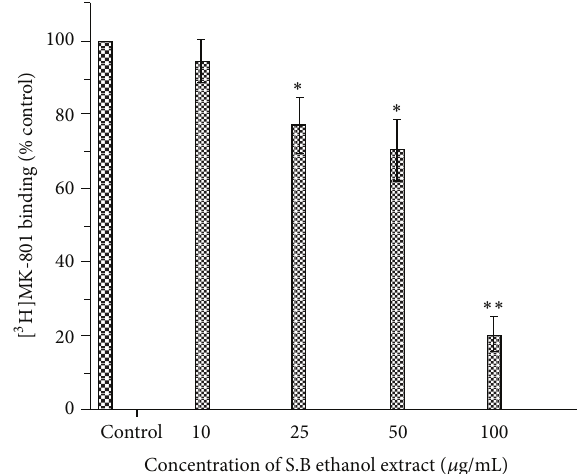
Figure 4: The ethanol extract of Scutellaria baicalensis inhibits the binding of [ 3 H]MK-801 to the N-methyl-D-aspartate (NMDA) receptor. Different concentrations of the extract (here we used 10, 25, 50, and 100 𝜇 g/mL) were employed. Nonspecific binding determined in the presence of 200 𝜇 M MK-801 was subtracted from the total binding. Data were calculated as percent of the control binding measured in the absence of the extract. Each point represents the mean ± S.D. ∗ 𝑃 < 0.05 ; ∗∗ 𝑃 < 0.01 (compared with control